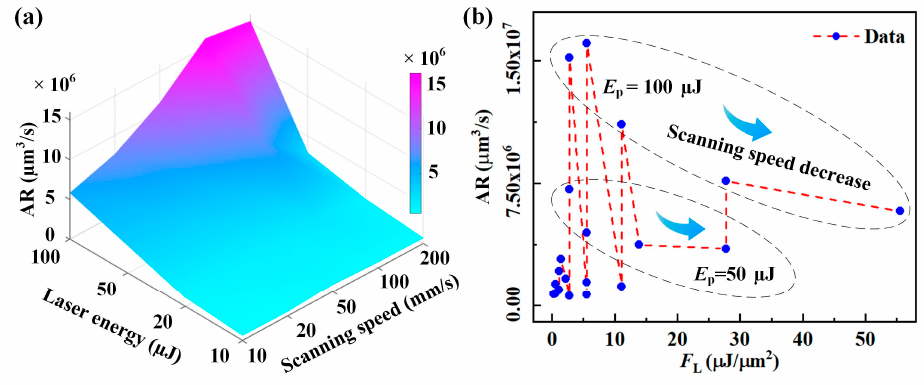
Figure 15. Effect of laser energy and scanning speed on AR. ( a ) Mapping of AR with laser energy and scanning speed. ( b ) The relationship between AR and F L .